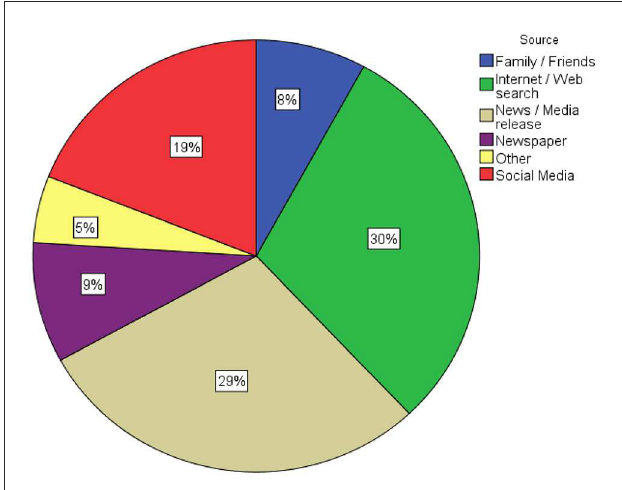
FIGURE1 Participants’ source of knowledge about the AstraZeneca vaccine.